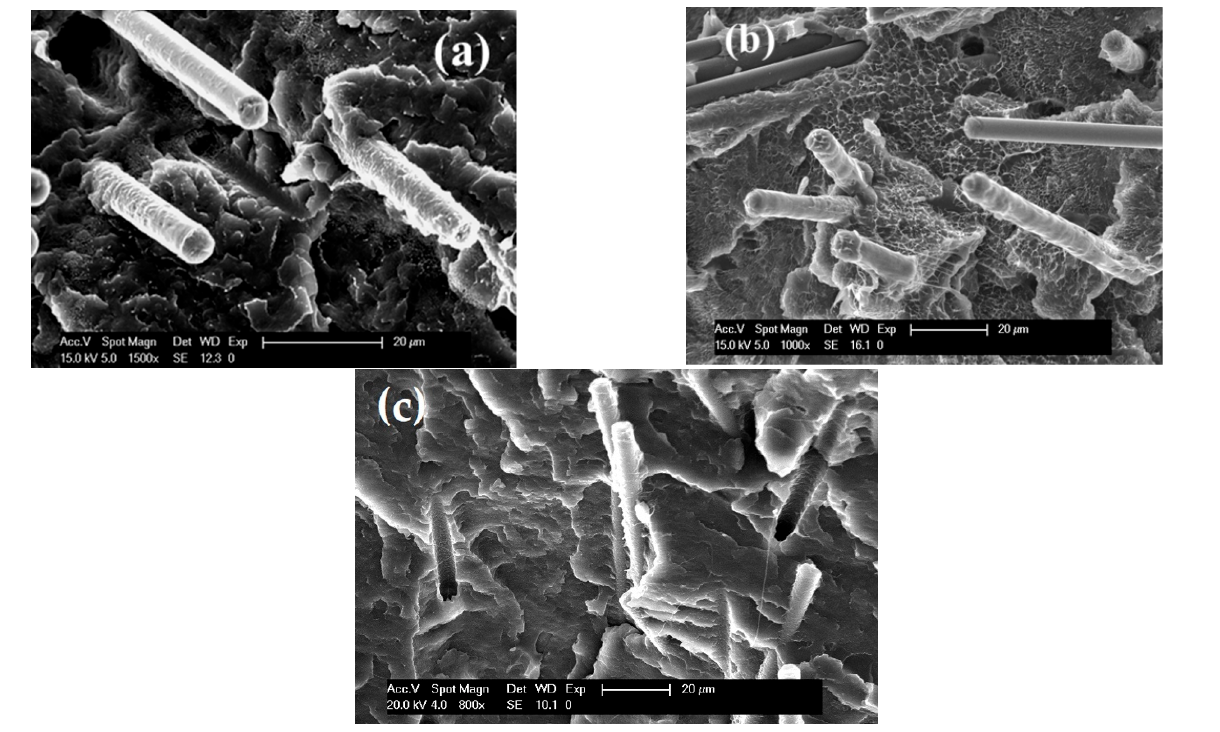
Figure 5. Morphology of the fracture surfaces of flexural tests: ( a ) CF/EP_PBT; ( b) CF/EP_Blend; ( c ) CF/EP/PC_PBT.